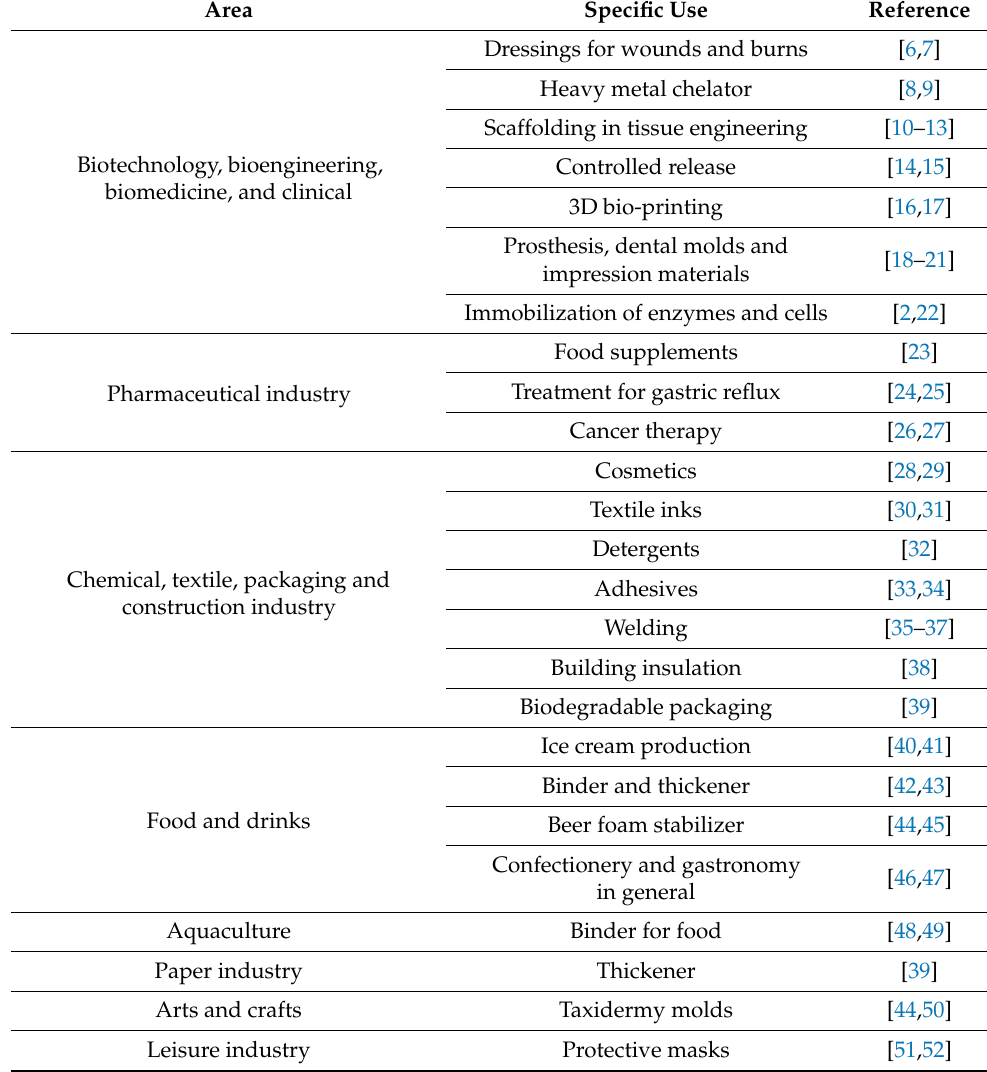
Table 1. Application areas of alginate and its specific